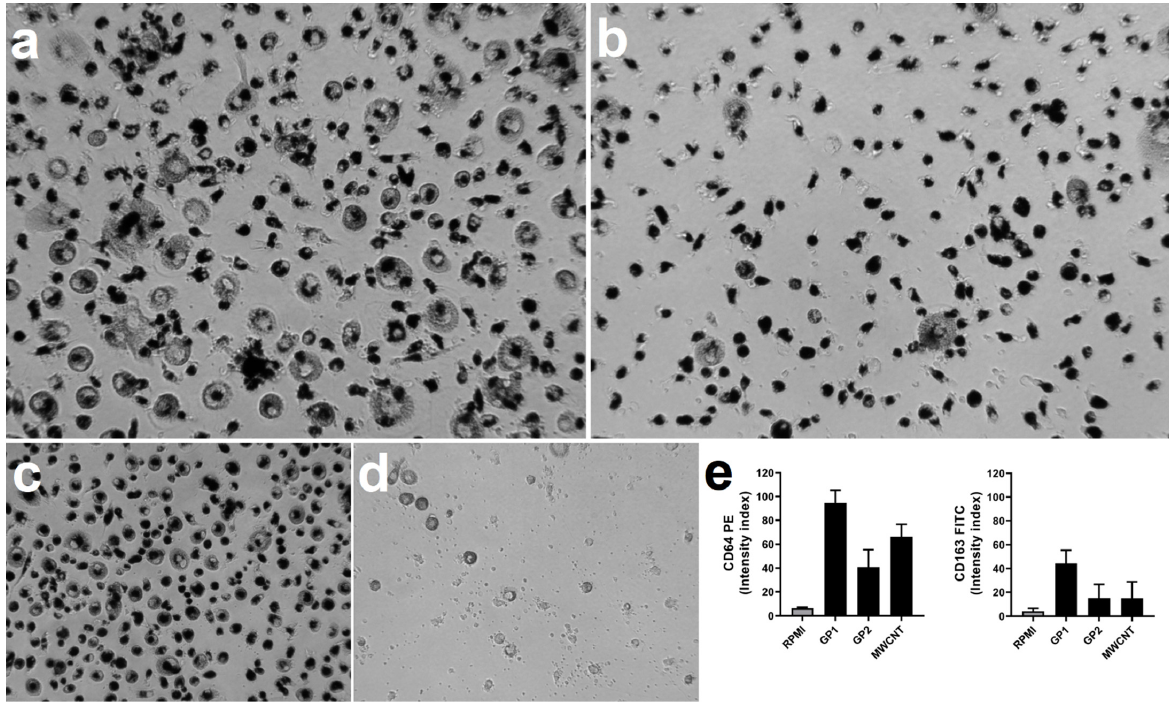
Figure 7. Morphology of cells after 24 h exposure and six days of differentiation with ( a ) GP1, ( b ) GP2, ( c ) MWCNTs and ( d ) RPMI. Magnification ×20. ( e ) Expression rate of CD64 and CD163 measured by flow cytometry. Data are normalized to control (RPMI) and presented as mean ± standard deviation. Indices were calculated according to unstained samples to eliminate autofluorescence.